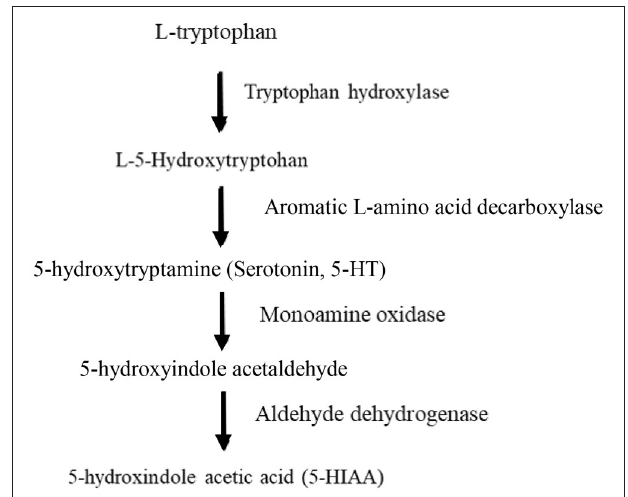
FIGURE 1 | Biosynthetic pathway of